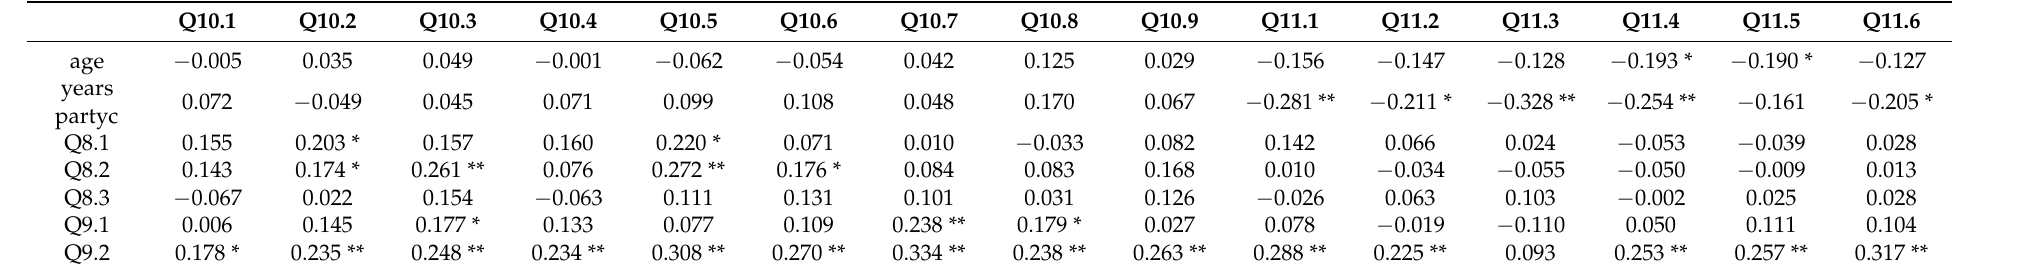
Table A2. Pearson’s correlation matrix, * significant at the alpha 0.05 level, ** significant at the alpha 0.01